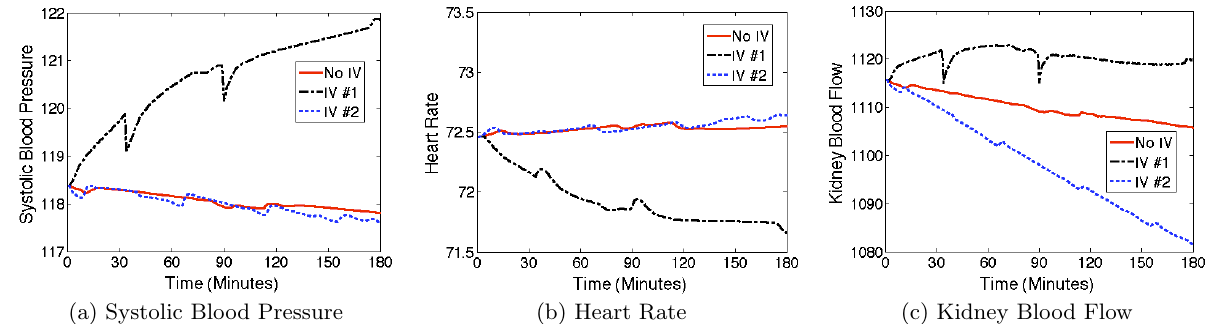
Figure 2: The effects of two interventions on the (a) Systolic Blood Pressure, (b) Heart Rate, and (c) Kidney Blood Flow.